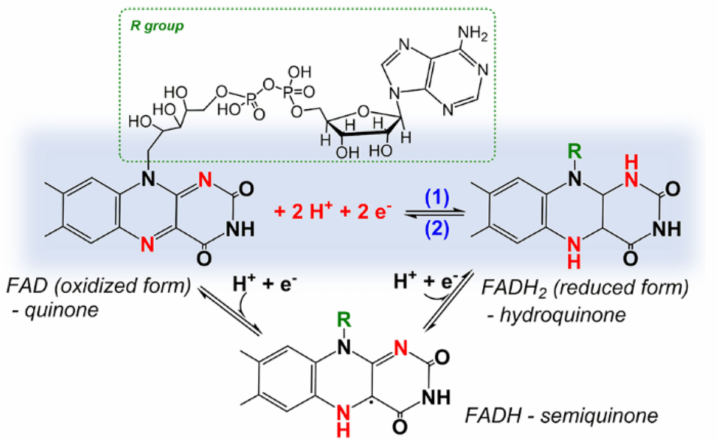
Scheme 2. FAD chemical structure and schematization of redox FAD reaction via the two- electron mechanism (quinone to hydroquinone, highlighted in blue) or the one-electron mechanism (semiquinone intermediary